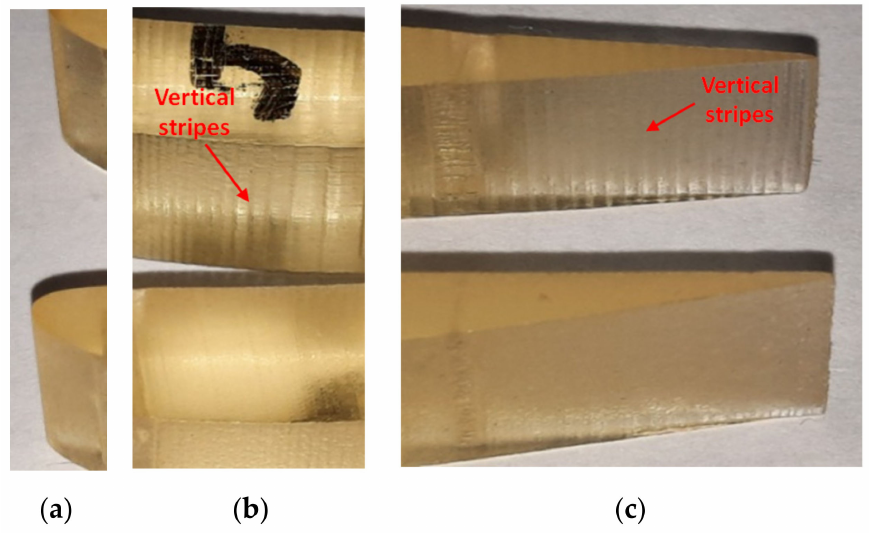
Figure 14. Comparative study of the airfoil surface in different interest locations for glossy XY (upper) and glossy YX (lower): ( a ) leading edge; ( b ) central zone; ( c ) trailing edge.